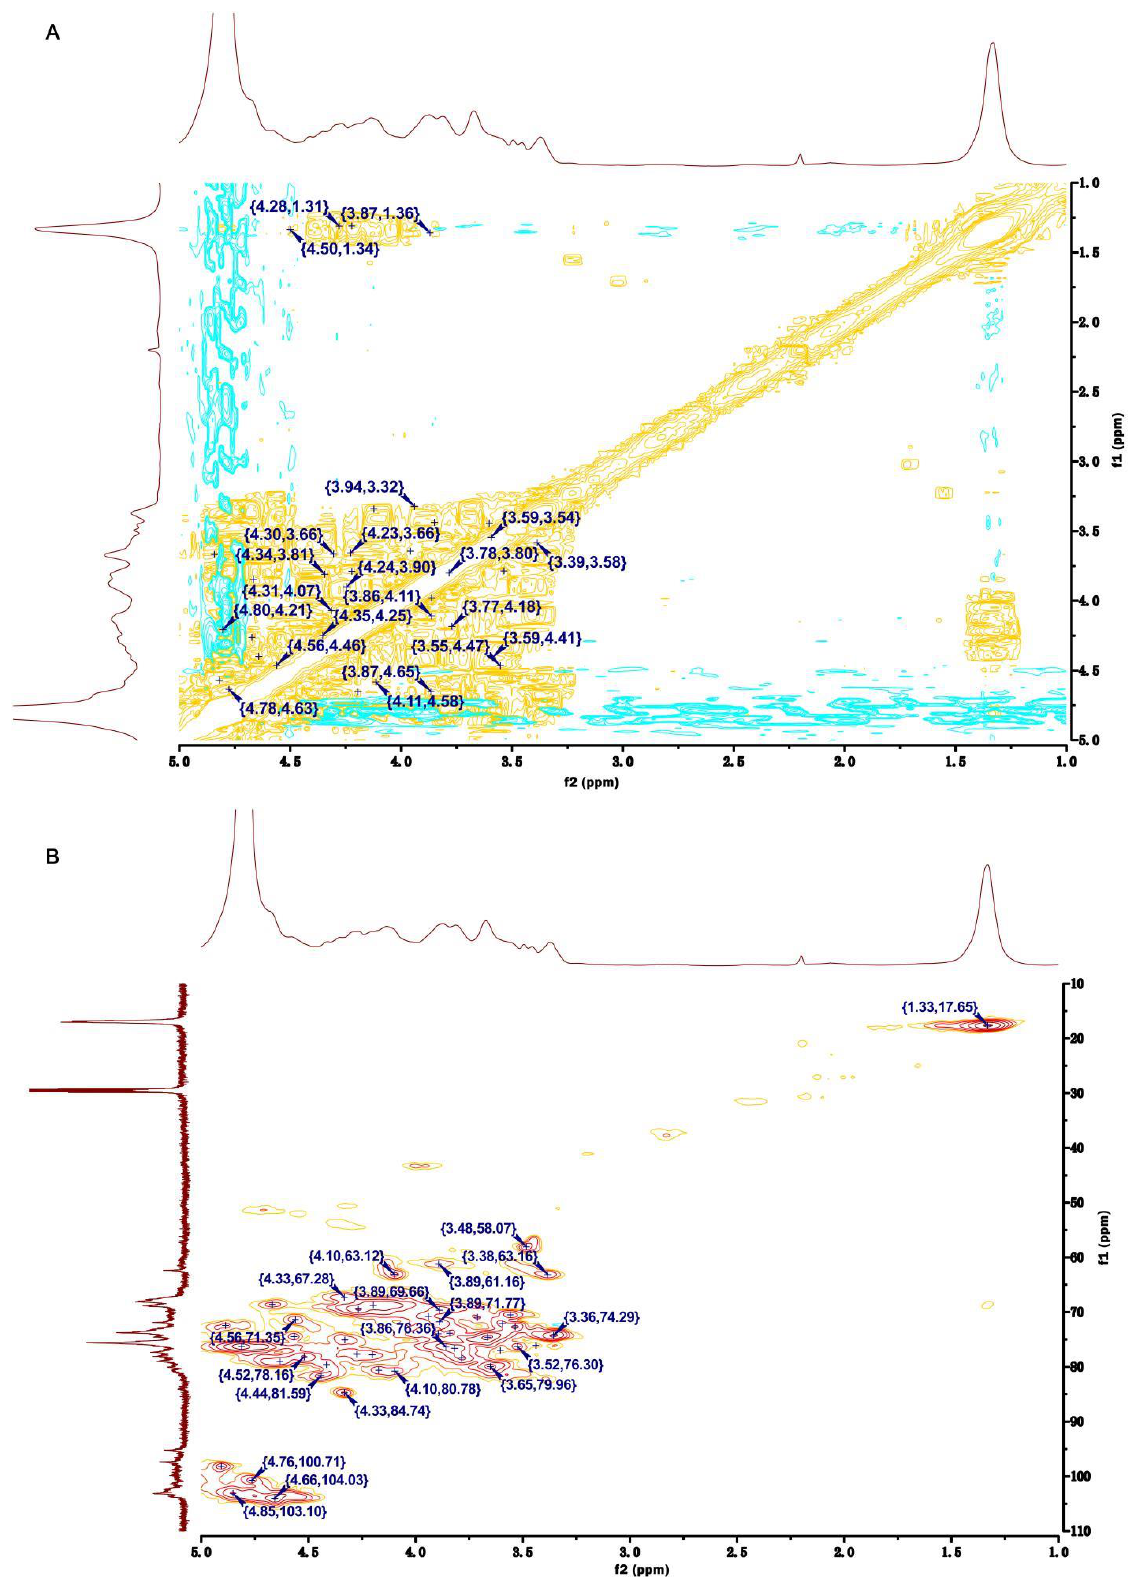
Figure 4. Two-dimensional NMR of HU. ( A ) COSY NMR of HU. ( B ) HSQC NMR of HU.